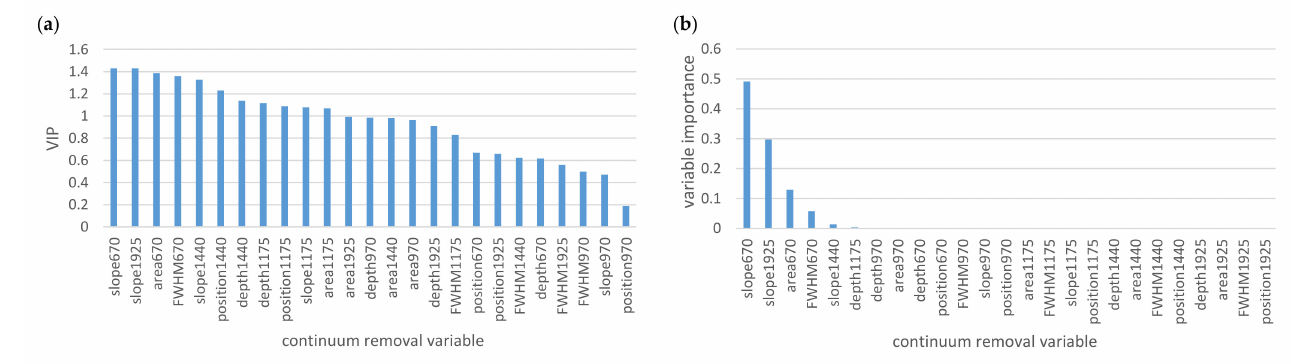
Figure 11. Variable importance for continuum removal variables computed by PLSR ( a ), and RFR ( b ).